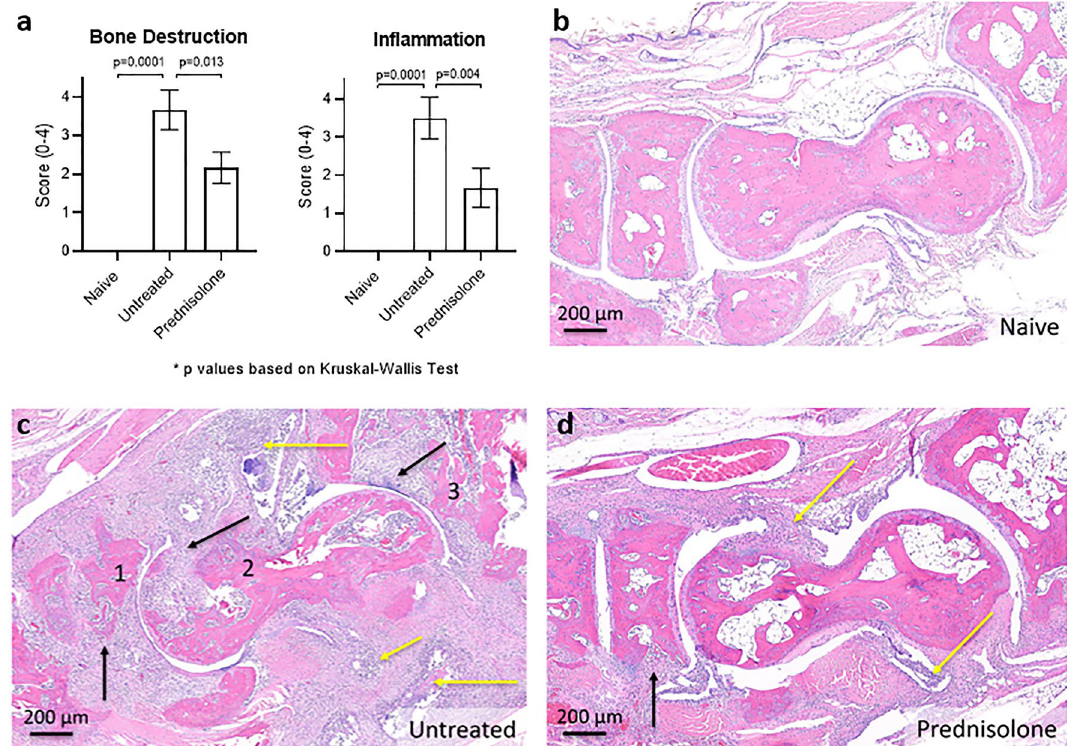
Figure 6. ( a ) Histopatholology scores of tarsal inflammation and bone destruction confirm disease in CIA mice, and show a significant reduction with prednisolone treatment. ( b–d ) Representative hematoxylin and eosin-stained images for each group are shown here with × 50 magnification. Black arrows indicate pannus causing bone erosion in the navicular (1), talus (2) and distal tibia (3). Yellow arrows indicate inflammation. The prednisolone-treated group has less inflammation (yellow arrows), and less bone erosion (black arrows; mainly in the navicular bone, while talus and distal tibia are less